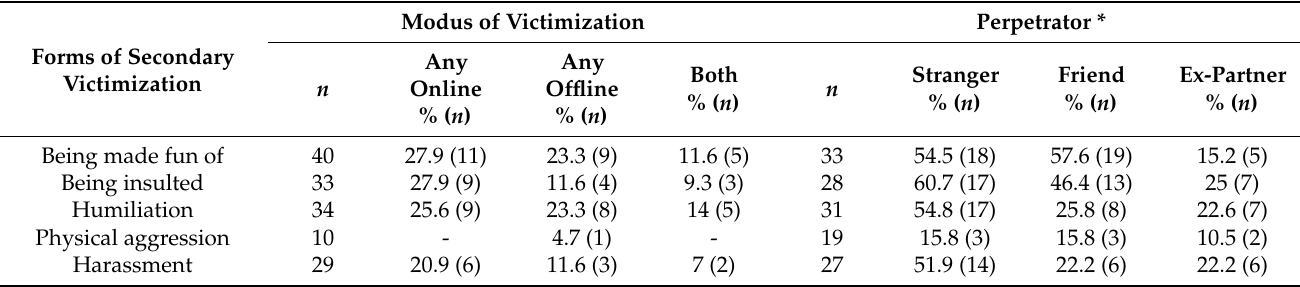
Table 2. Prevalence rates for the forms of secondary victimization as a result of non-consensual dissemination of sexting by modus and